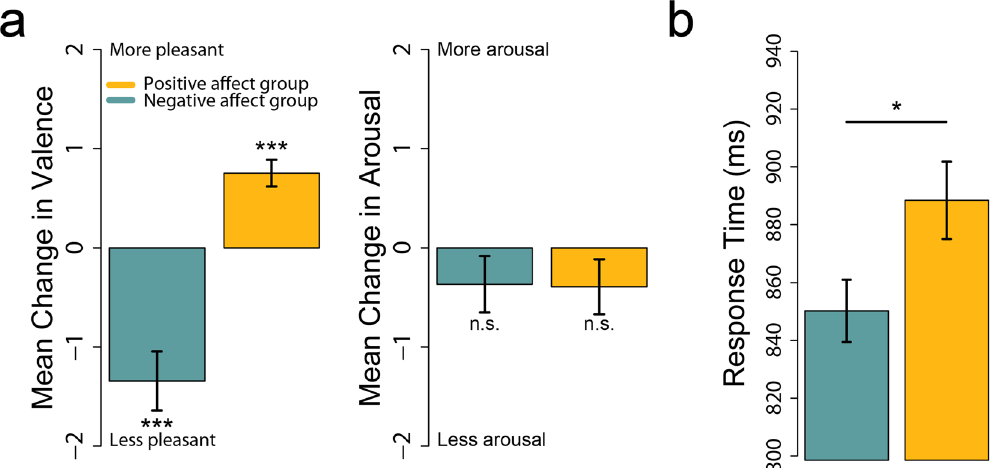
Figure 1. Confirmation of affect induction, and influence of affect on response time. ( a ) Affect induction periods induced a change in self-reported valence, but not arousal. ( b ) During the object recognition task, the negative affect group displayed faster response times than the positive affect group. Error bars indicate standard error of the